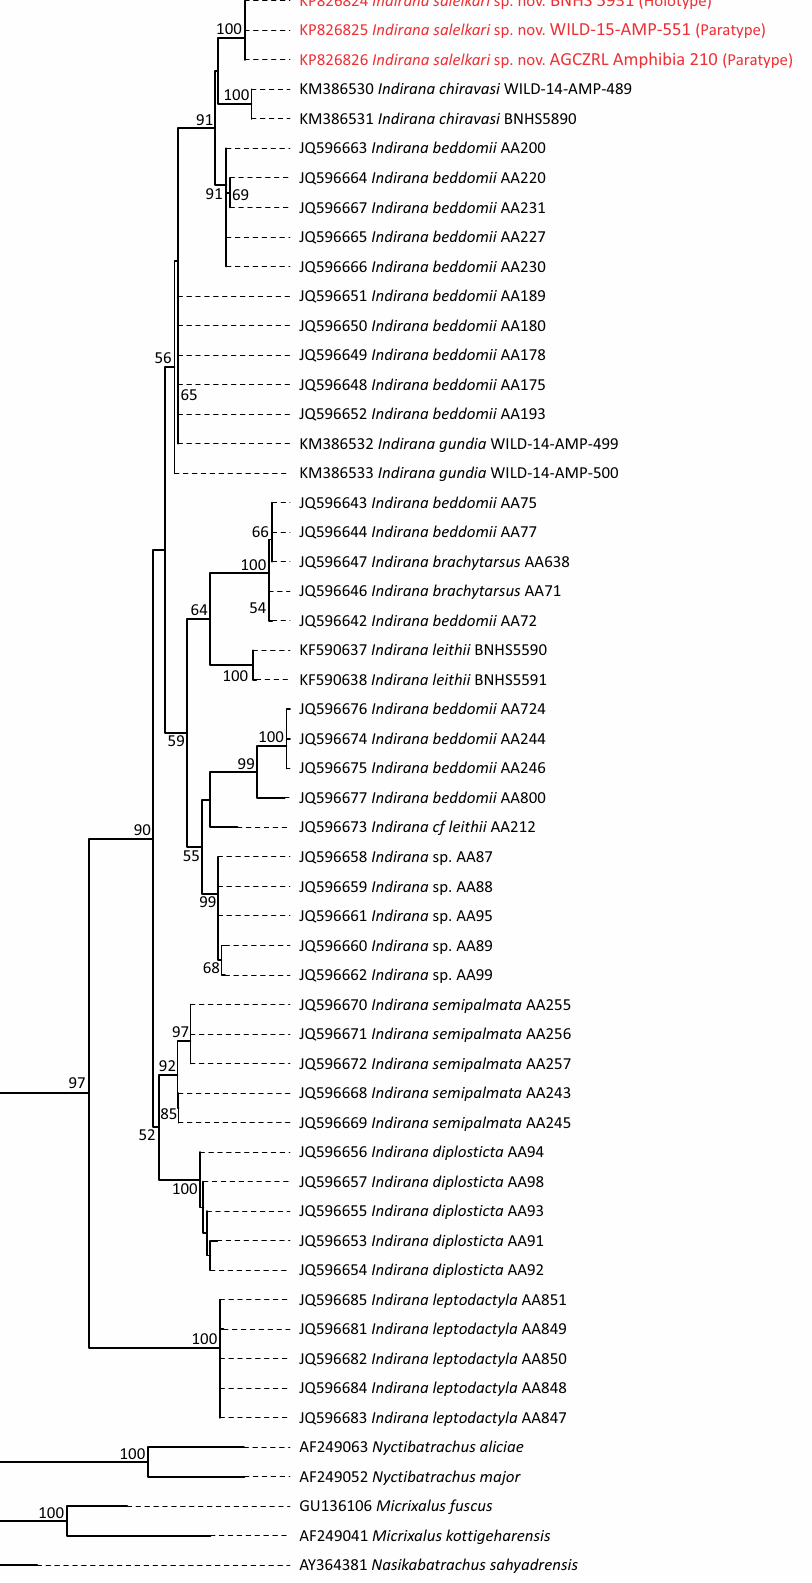
Figure 2. Maximum likelihood tree based on GTR+G (BIC = 6137.51, lnL = -2496.68, G = 0.37) nucleotide substitution model for 16s rRNA gene sequences. Values along the nodes are percent bootstraps for 1000 iterations. Nasikabatrachus sahyadrensis is used as an